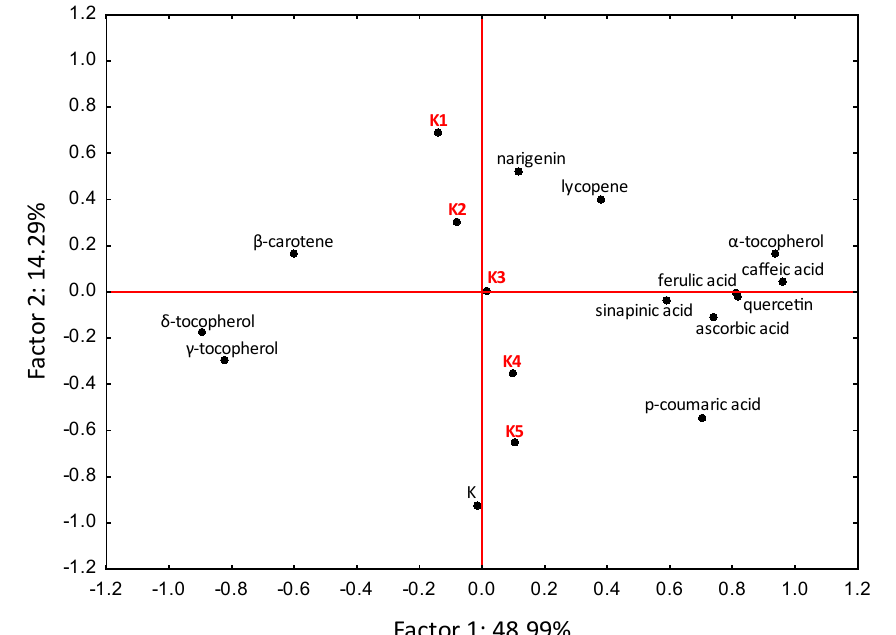
Fig. 1: Principal component analysis of the antioxidants in relation to the increasing K levels in 2014. K levels increase from K1 to K5 (0.37 g, 0.73 g, 1.47 g, 2.2 g, and 3.66 g K 2 SO 4 per week). K represents the K concentration in the tomato fruit.